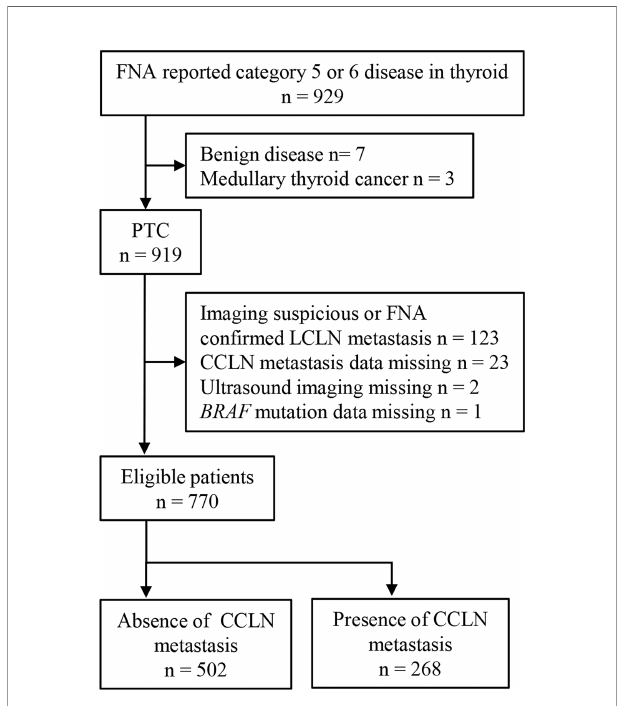
FIGURE 1 | The fl ow chart of patient